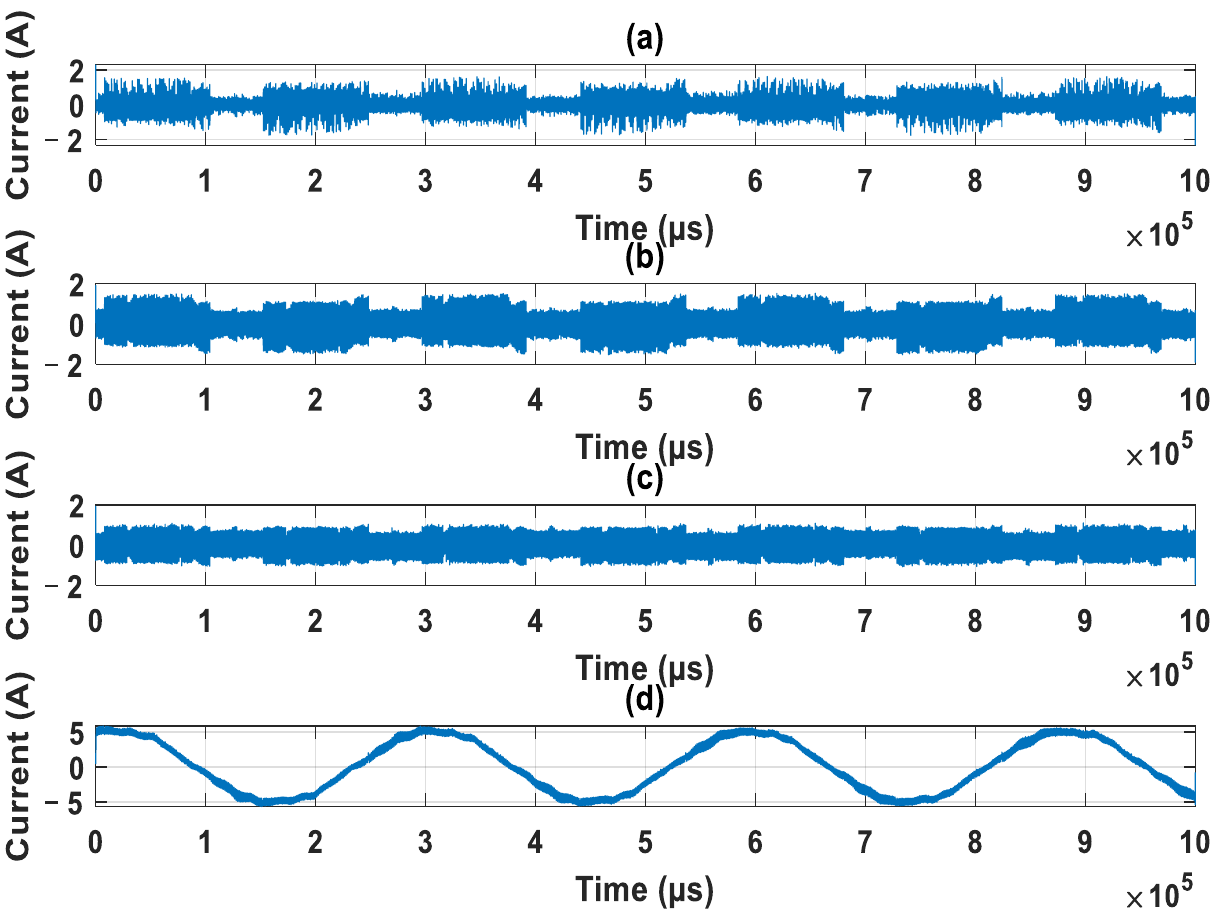
Figure 7. The measured current signal. ( a ) Original signal in the time domain, ( b ) Fourier transform of the signal.